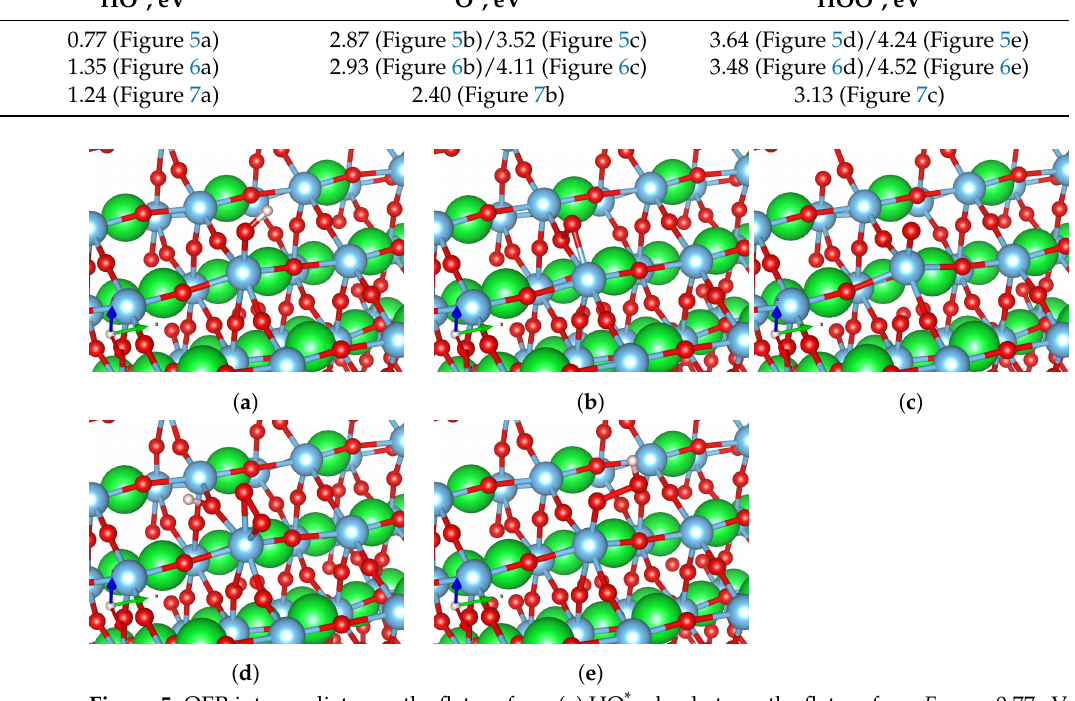
Figure 5. OER intermediates on the flat surface. ( a ) HO * adsorbate on the flat surface: E ads = 0.77 eV. ( b ) O * (O adsorbate on the flat surface: E ads = 2.87 eV. ( c ) O * adsorbate on the flat surface: surf ) E ads = 3.52 eV. ( d ) H (O OO * adsorbate on the flat surface: E ads = 3.64 eV. ( e ) HOO * adsorbate on surf ) the flat surface, standard configuration: E ads = 4.24